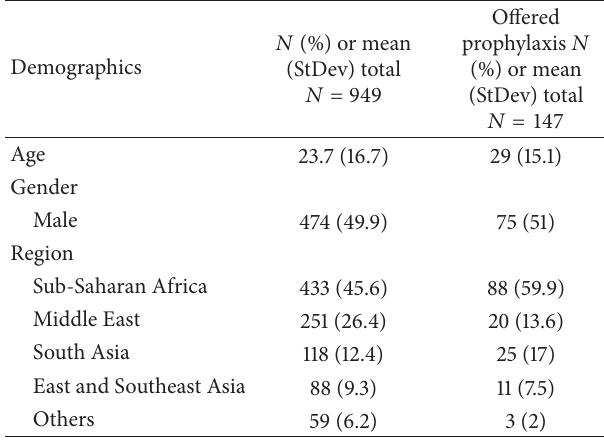
Table 1: Demographic information.